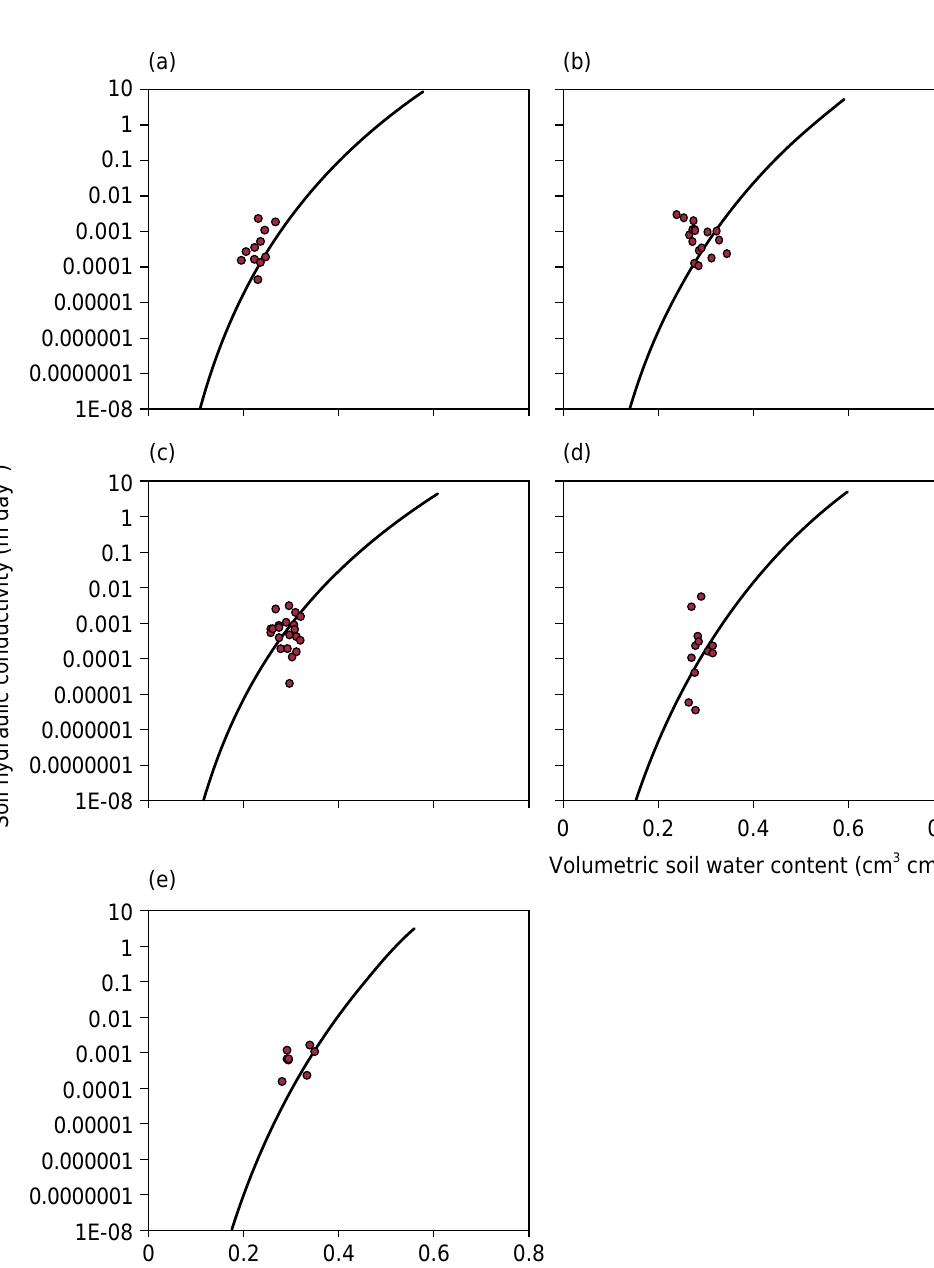
Figure 5. Comparison between the point values of soil unsaturated hydraulic conductivity ( K ) determined in this study, and the pedotransfer equation for K ( θ ) proposed by Tomasella and Hodnet (1997) for the different soil profile depths. (a) 0.15 m depth; (b) 0.3 m depth; (c) 0.45 m depth; (d) 0.6 m depth; and (e) 0.9 m